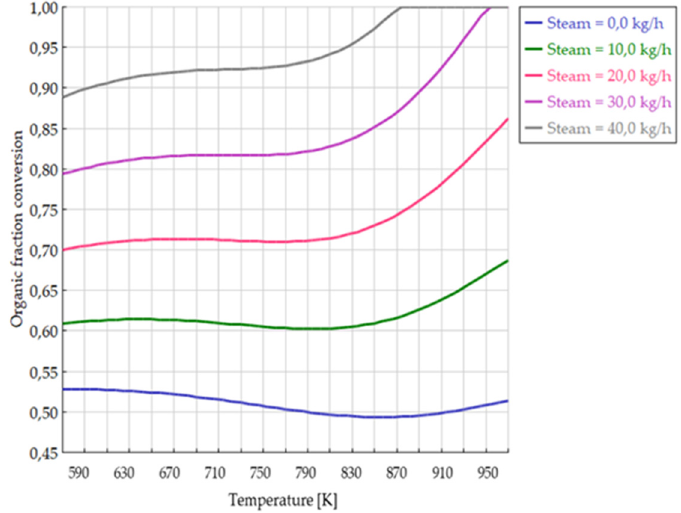
Figure 7. The effect of temperature over organic fraction conversion for different steam streams (a feed stream of 100